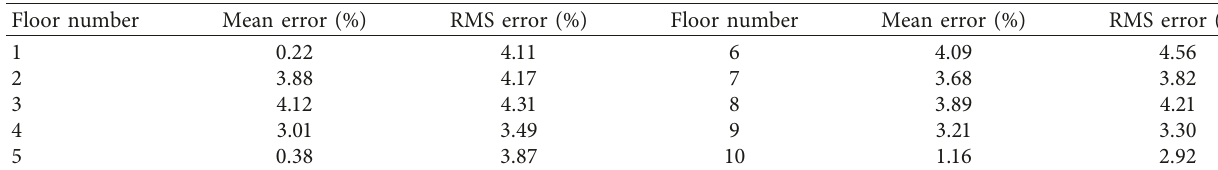
Figure 5: Comparison of the wind load time histories. Wind load on the (a) fifth floor and (b) tenth floor. Wind load errors on the (c) fifth floor and (d) tenth floor. Table 2: Mean errors and RMS errors for wind load